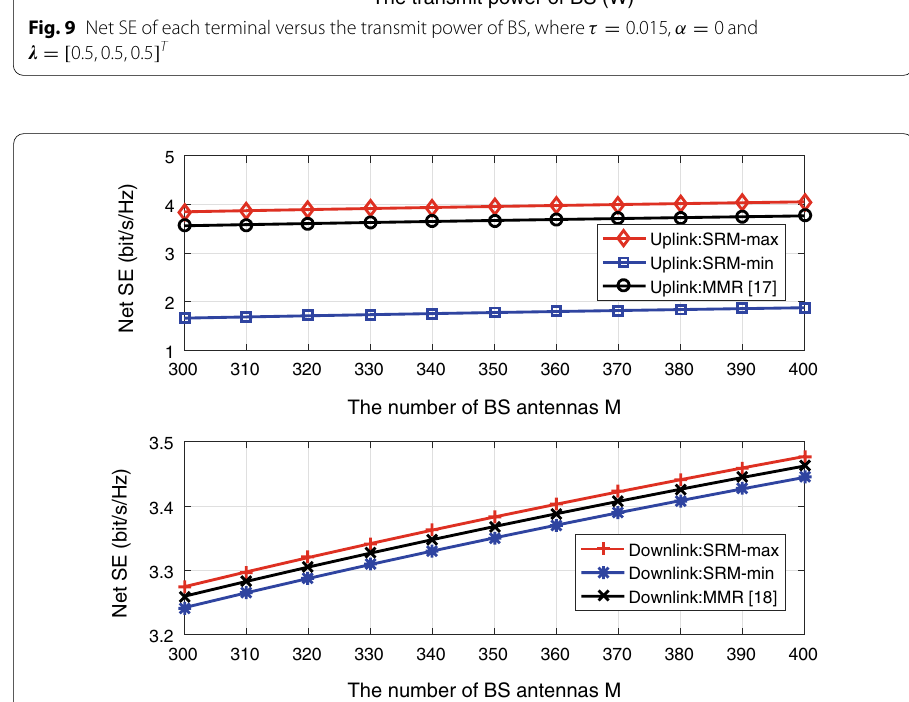
Fig. 10 Net SE of uplink and downlink data transmission versus the number of BS